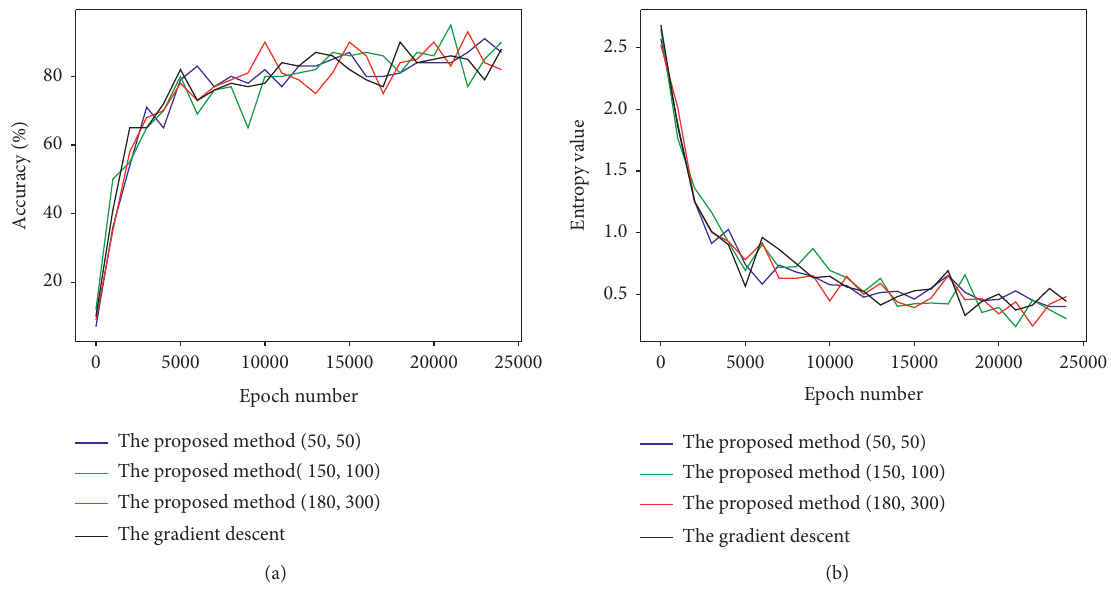
Figure 7: Speech recognition performance: (a) accuracy after each learning step; (b) cross entropy after each learning